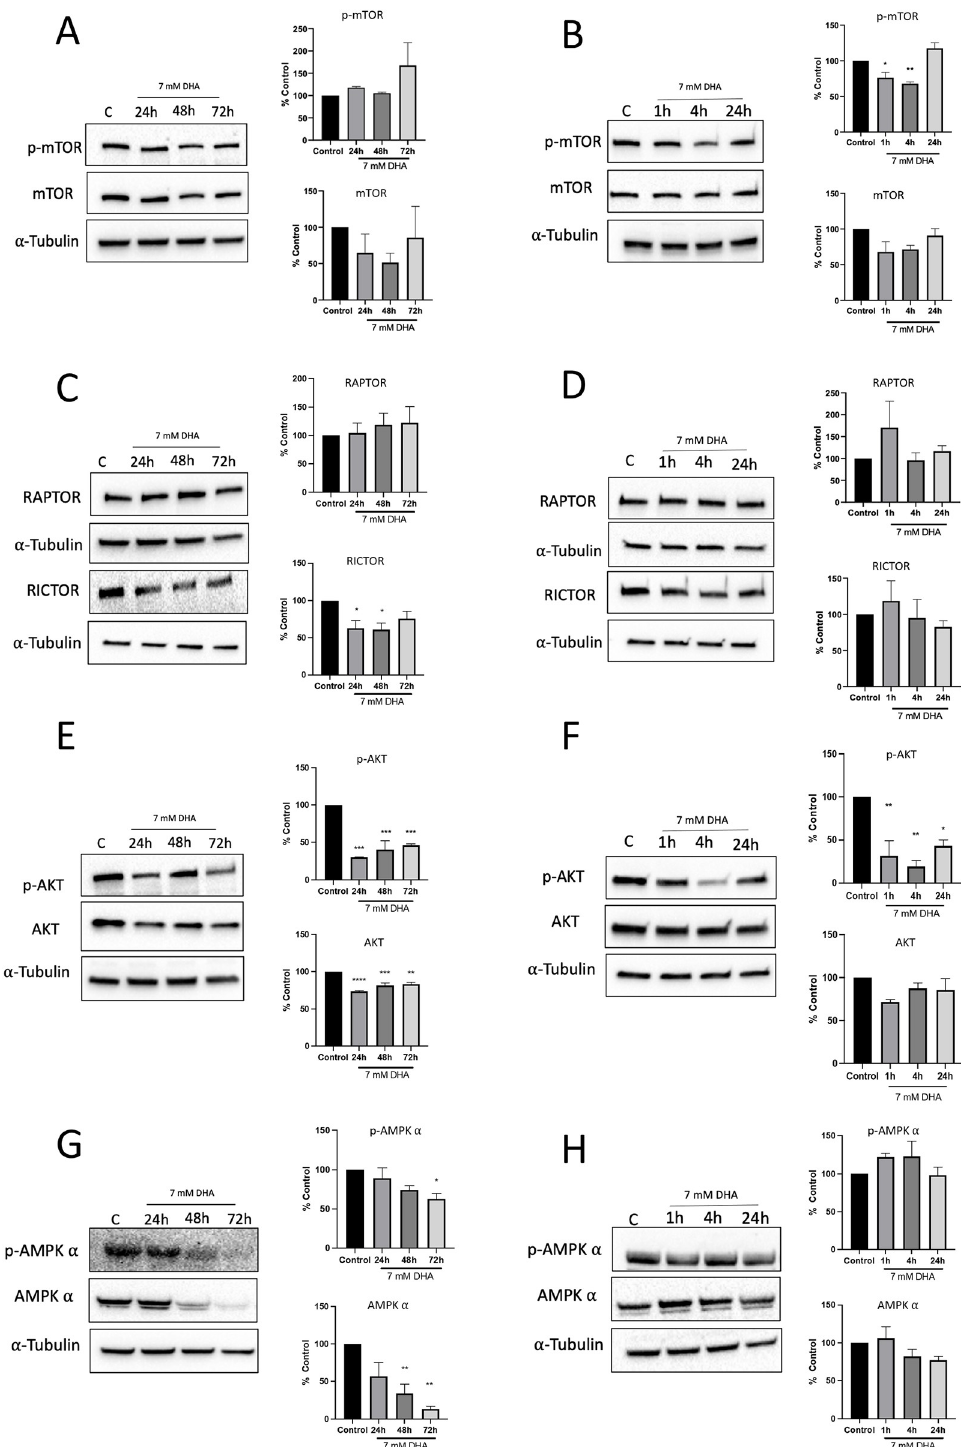
Fig 5. Changes in nutrient sensing mechanisms when cells are exposed to DHA. (A) mTOR signaling was evaluated using p-mTOR and mTOR markers when dosed with 7 mM DHA at 24, 48, and 72 h. Slight increases in p-mTOR were found, while mTOR displayed fluctuating levels at these time points. (B) p-mTOR and mTOR levels at 1, 4, and 24 h showed a significant decrease at 1 and 4 h, while mTOR decreased slightly at all time points. (C) RICTOR significantly diminished at 24 and 48 h, while RAPTOR slightly increased. (D) RICTOR and RAPTOR levels displayed fluctuating